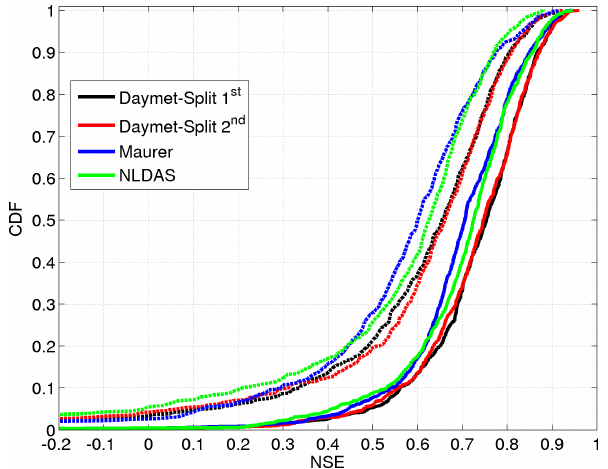
Figure 8. Cumulative density functions for model Nash–Sutcliffe efficiency for the calibration (solid) and validation (dashed) periods using three different forcing data sets (Daymet, Maurer, NLDAS). The Daymet data set was calibrated using the first 15 years (Split 1st) and validated against the remaining data and also calibrated using the last 15 years (Split 2nd) and validated against the initial streamflow data. Maurer and NLDAS calibrations performed using the first 15 years of observed streamflow only.